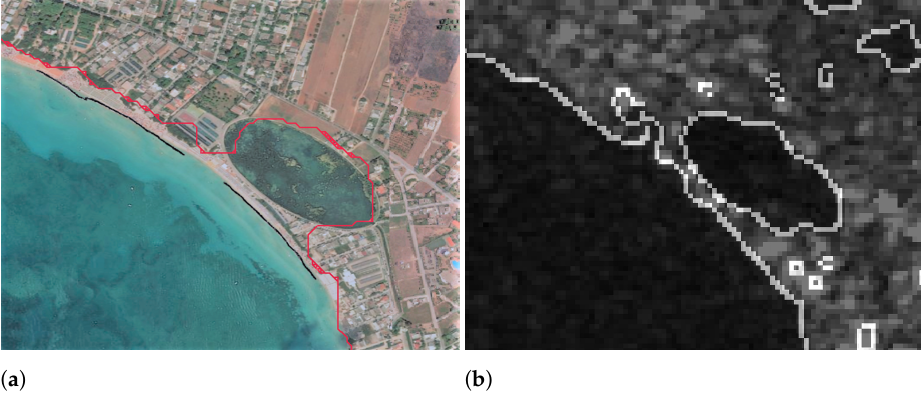
Figure 10. Comparison between the Torre Lapillo shoreline extracted by using ( a ) VH polarized image and VV images and a ( b ) VV polarized